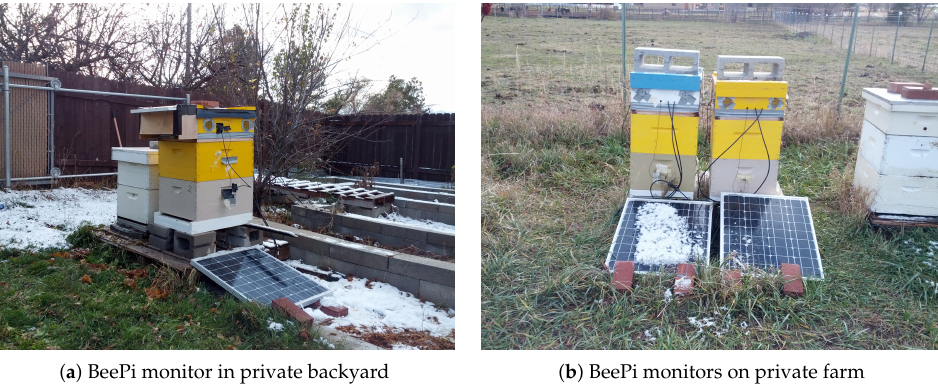
Figure 1. BeePi monitor ( a ) with a solar panel on the side; two BeePi monitors with solar panels behind the